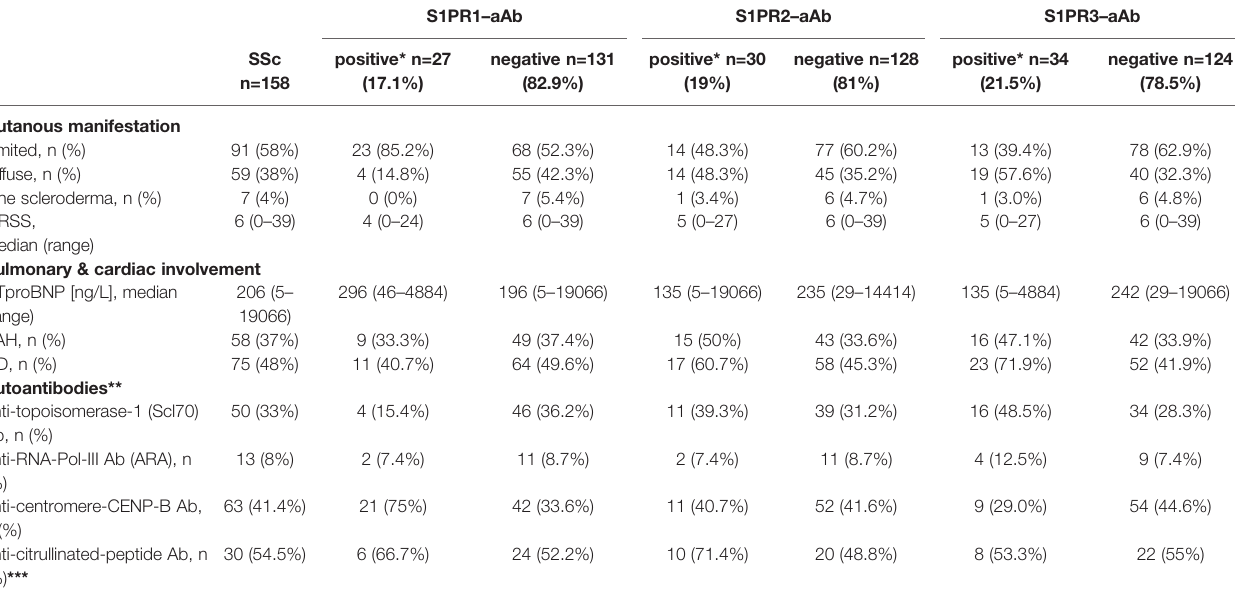
TABLE 2 | Characterization of the cohort of patients with systemic sclerosis regarding S1PR –